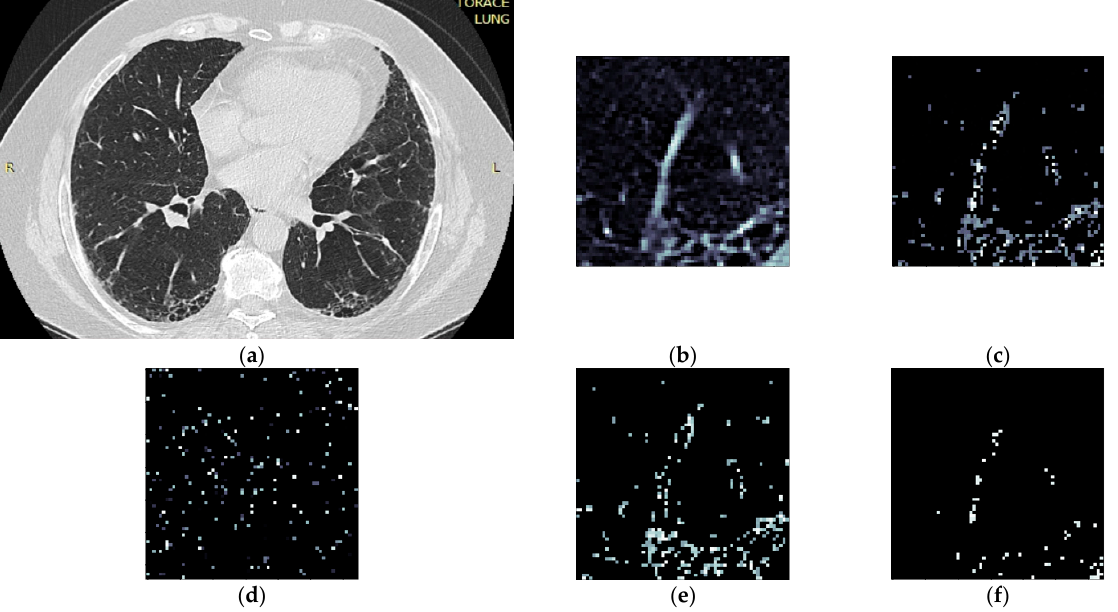
Figure 2. Splitting CT sample into layers ( a ) original CT, ( b ) sample crop, ( c ) combined Emphysema, GGO, and Consolidation layers, ( d ) Emphysema layer, ( e ) GGO layer, ( f ) Consolidation